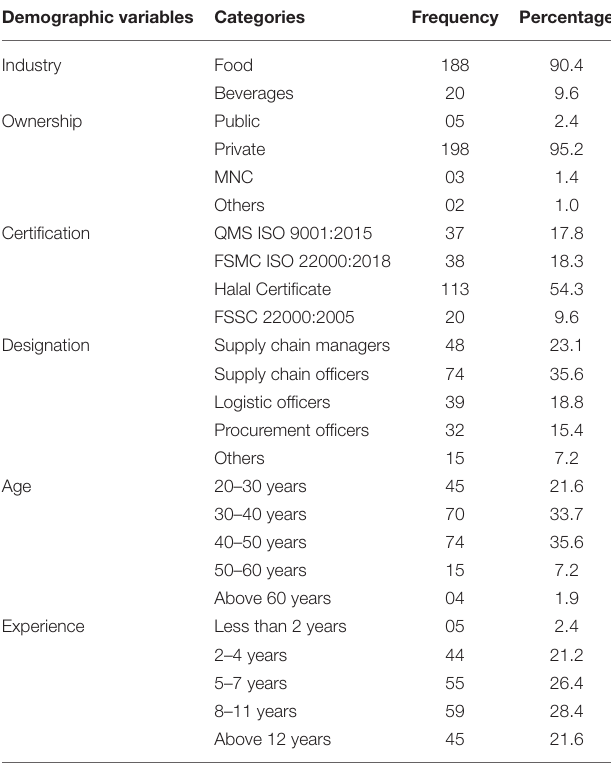
TABLE 1 | Demographic information of the participants ( N =